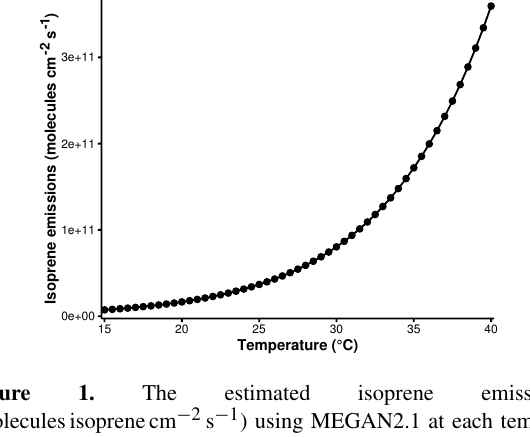
Figure 1. The estimated isoprene emissions (moleculesisoprenecm − 2 s − 1 ) using MEGAN2.1 at each temper- ature used in the